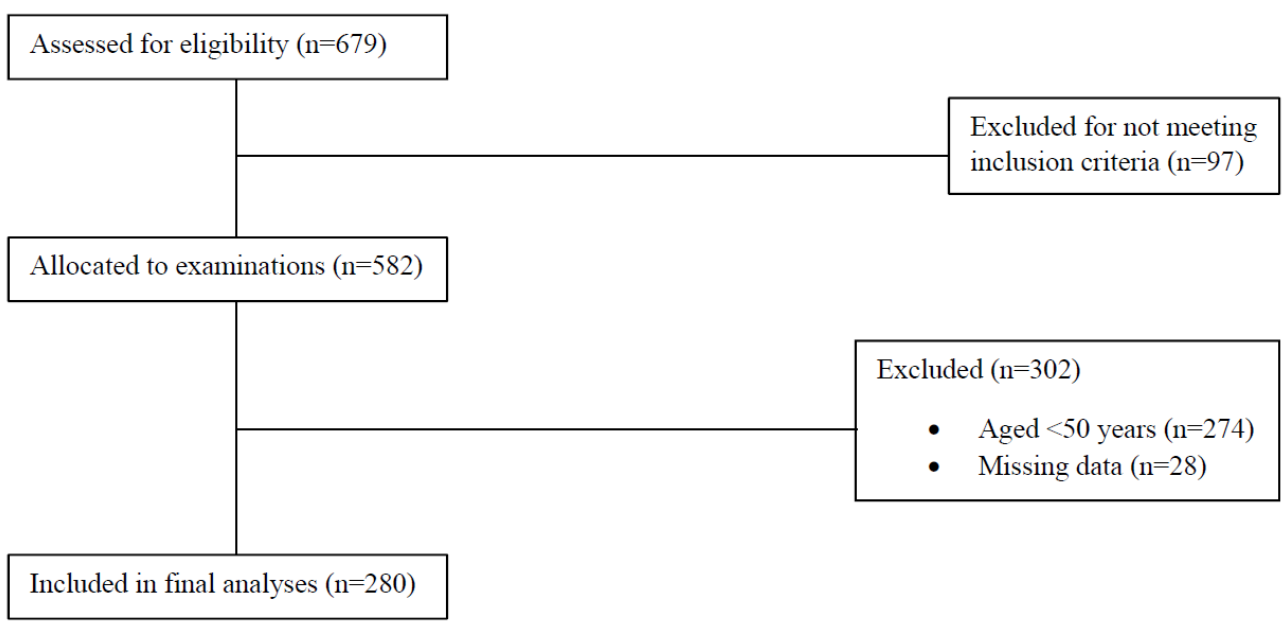
Figure 1. Flowchart of participant recruitment and data acquisition.